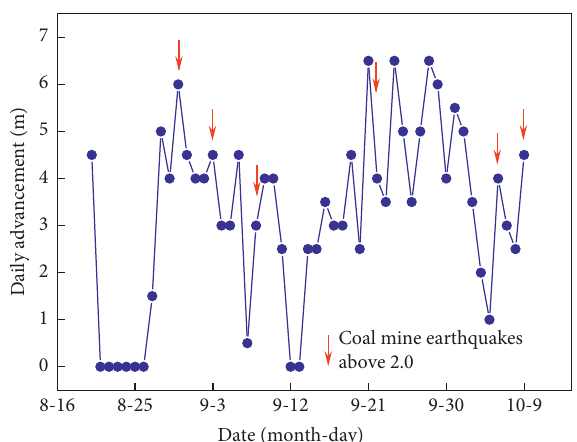
Figure 5: Relationship between coal mine earthquake and daily